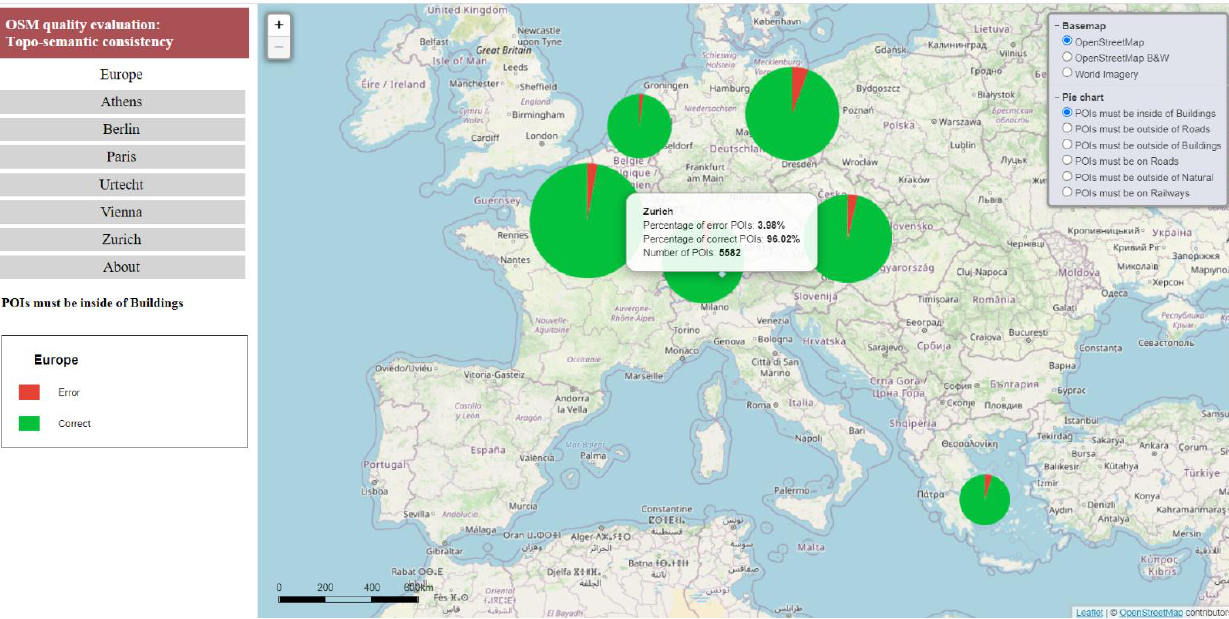
Figure 8. At the regional level, topo-semantic errors for each check (e.g., “POIs must be inside buildings”) are portrayed with a pie chart for each city. Additional information is provided by clicking on the symbol.